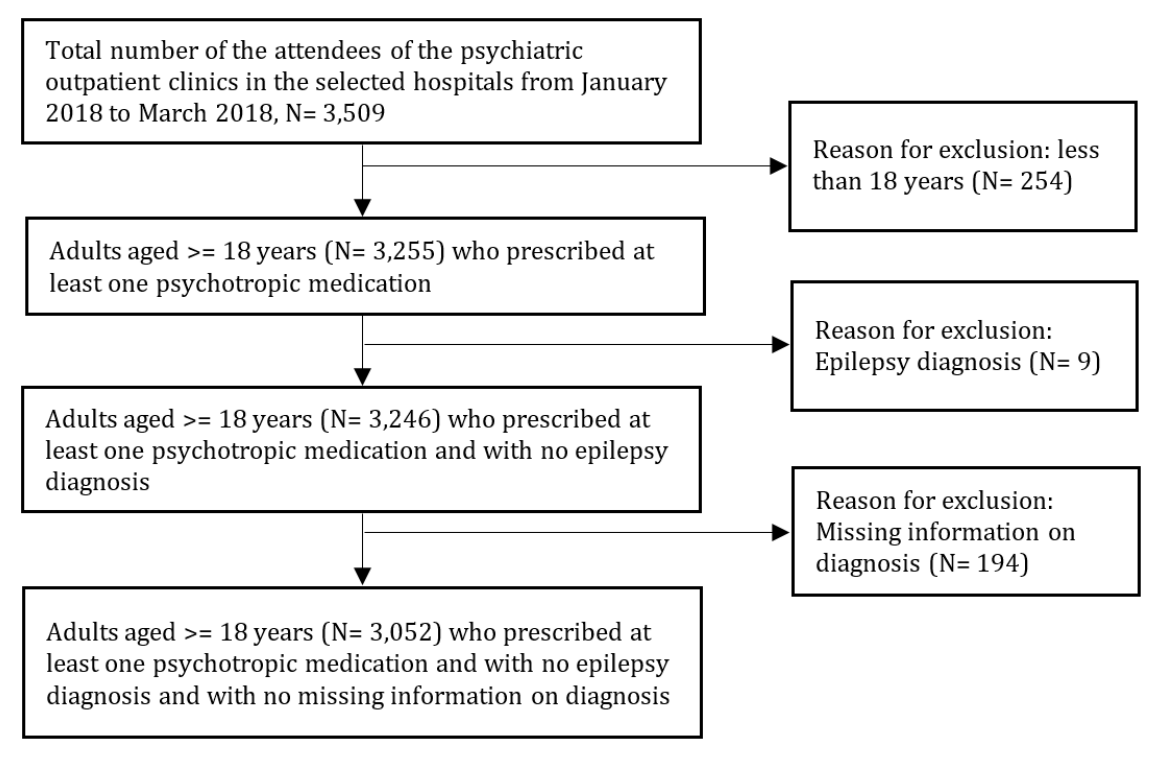
Figure 1: Description of Sample